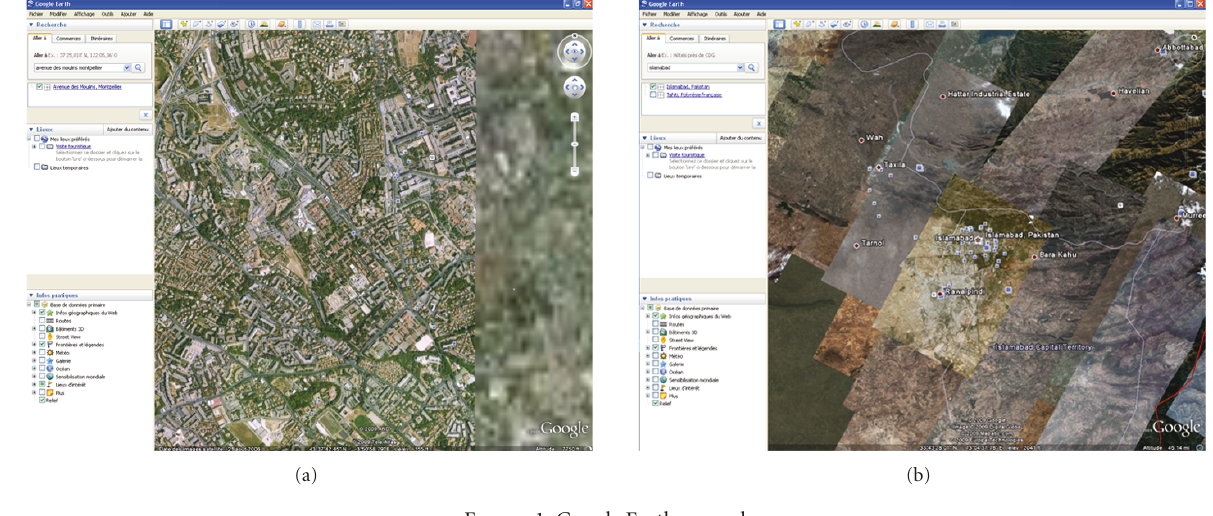
Figure 1: Google Earth